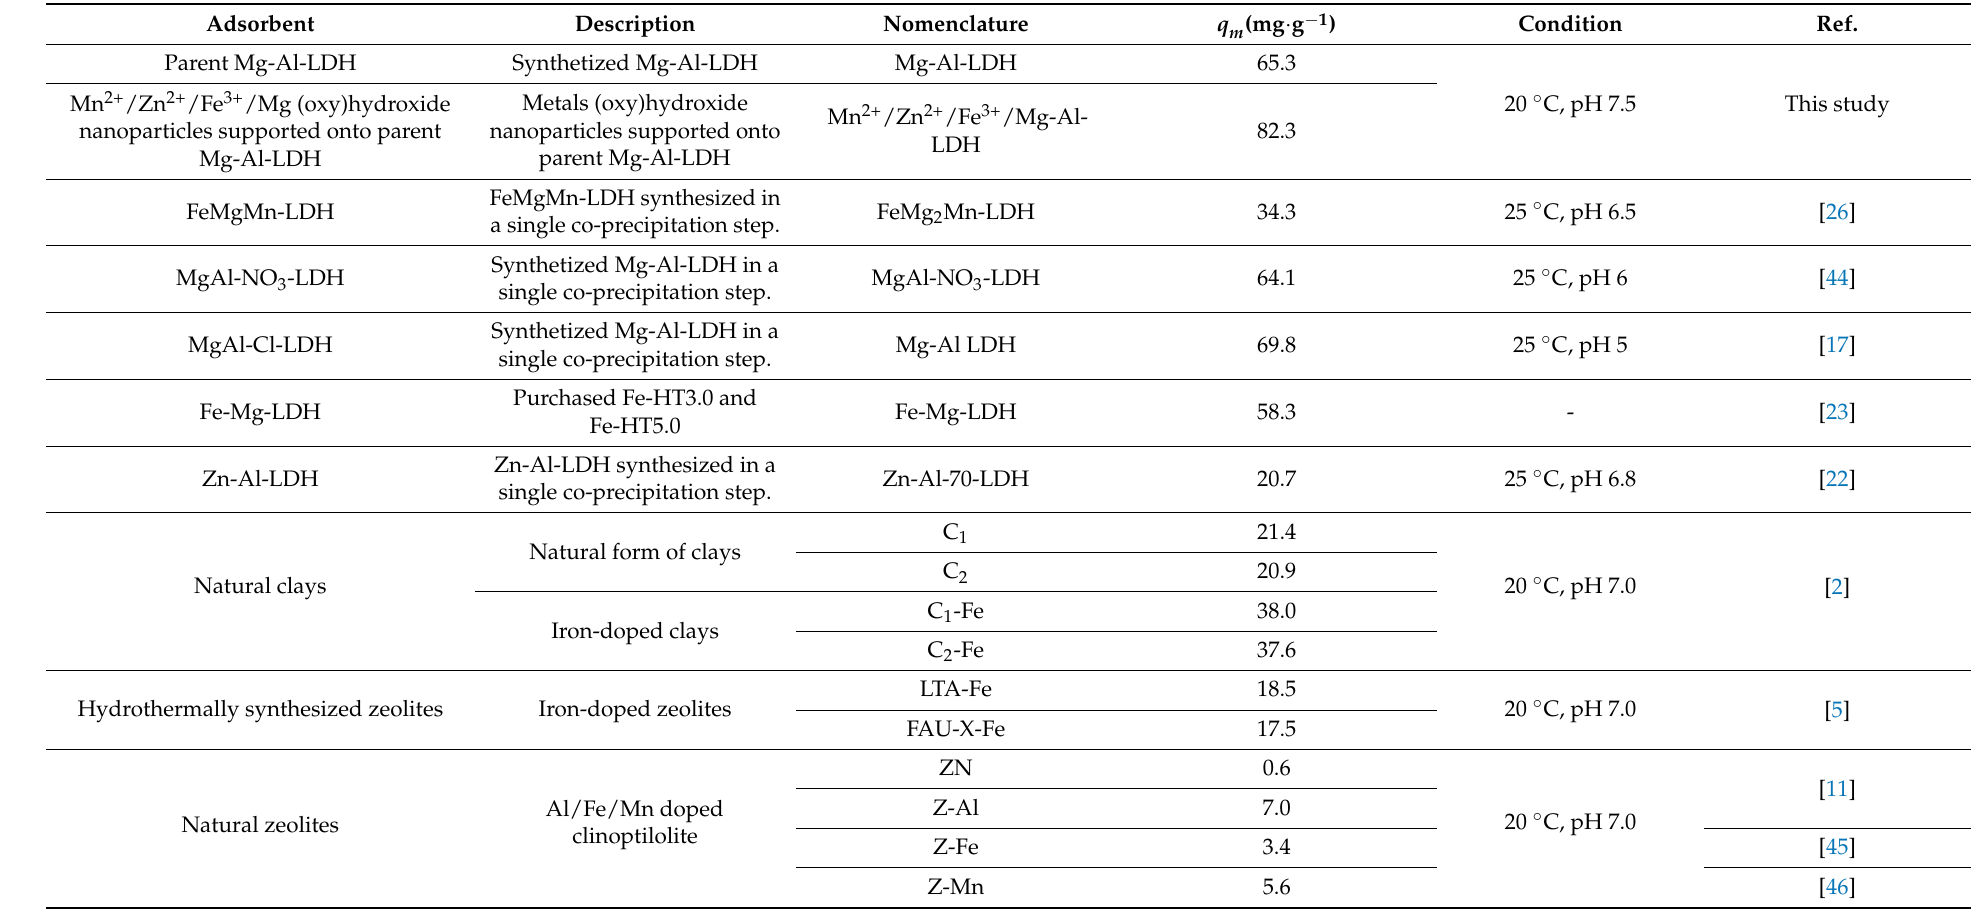
Table 2. Comparison of phosphate adsorption capacities of some LDHs